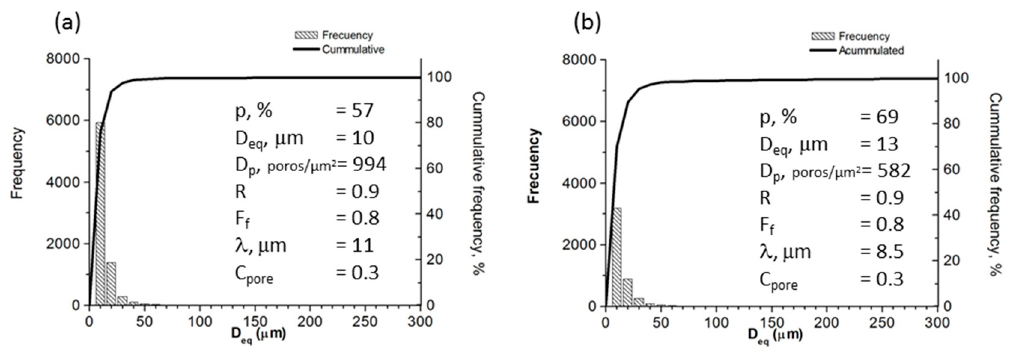
Figure 7. Results of optical image analysis of foams designed with ( a ) 50% and ( b ) 60 % porosity.